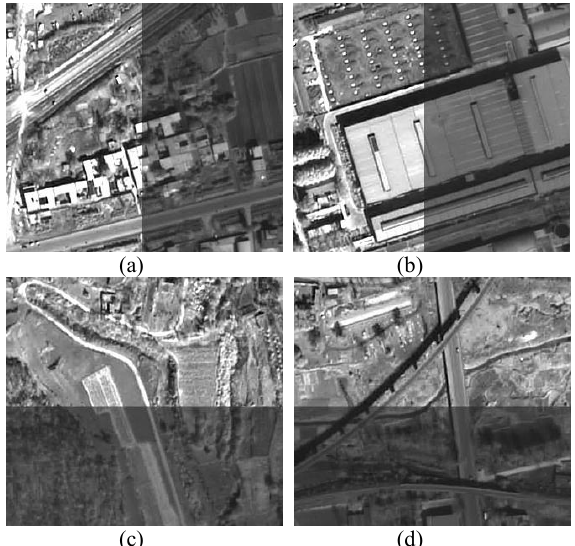
Figure 3. Stitching effect of Henan test area. (a) and (b) across track stitching effect, and (c) and (d) along track stitching effect